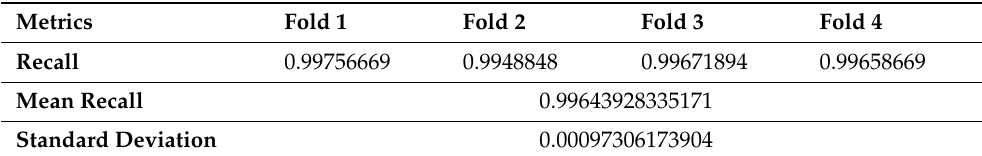
Table 9. EfficientNetB0 model: Recall score per fold.